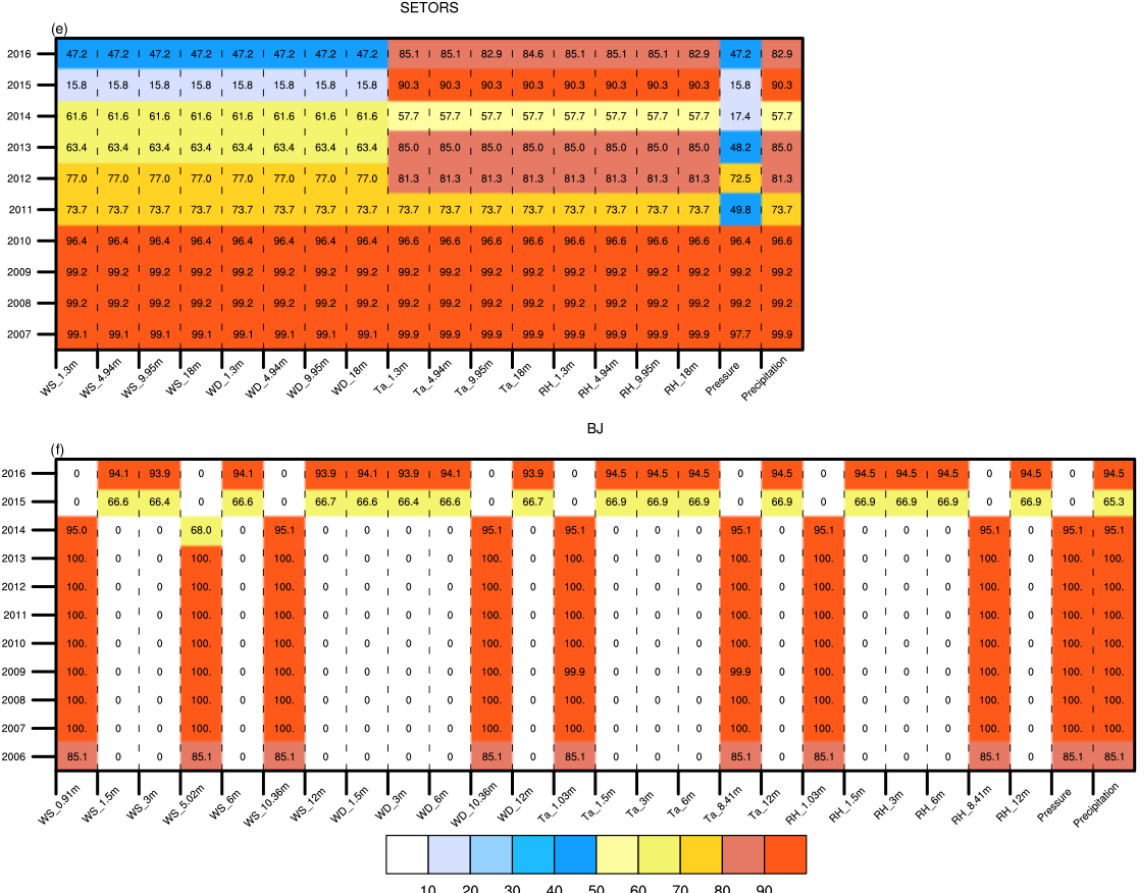
Figure A1. The annual data integrity of the gradient meteorological observing elements at different levels, with a value of 100 indicating complete continuous data, with no missing data. WS and WD represent wind speed and direction, respectively, followed by heights of each level with the underline symbol as connection. Ta refers to the air temperature. Relative humidity and water vapor pressure are expressed using RH and Vapor,